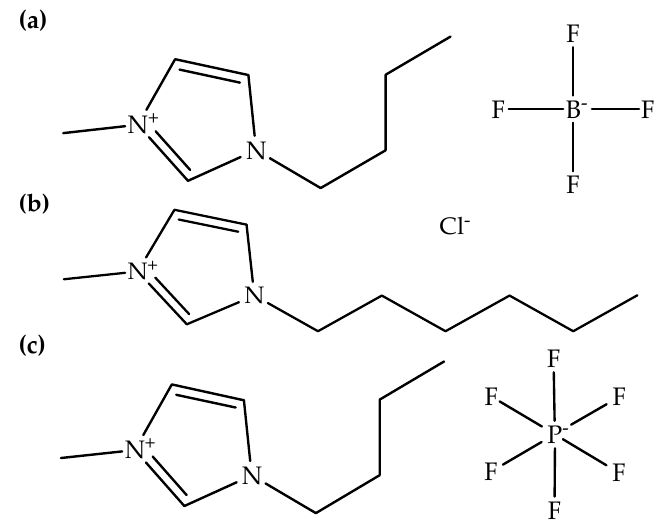
Figure 4. Chemical structures of ( a ) [C 4 mim][BF 4 ], ( b ) [C 6 mim][Cl], and ( c ) [C 4 mim][PF 6 ].